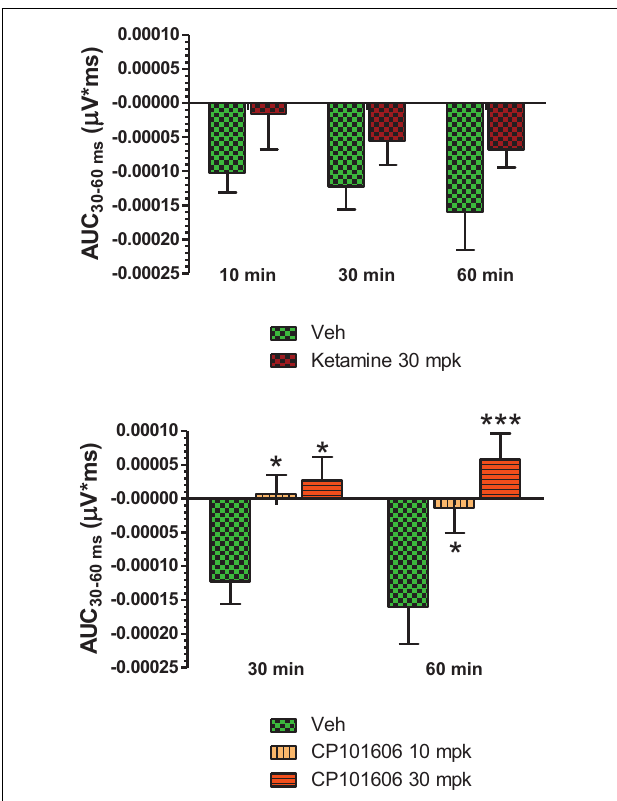
FIGURE 6 |Top panel , AUC 30–60ms of difference waves contrasted after vehicle or ketamine (10mg/kg, ip) treatment at three time points.Two-way ANOVA with repeated measures revealed a strong overall treatment effect [ F (1) = 8.44; P = 0.0068]. Bottom panel , AUC 30–60ms values contrasted after vehicle and CP-101,606 (10 or 30mg/kg, sc) treatment.Two-way ANOVA with repeated measures showed a strong overall treatment effect [ F (2) = 11.86; p < 0.0001]. */***Indicates significant difference ( P < 0.05/ P < 0.0001) between vehicle and respective CP-101,606 treatment.